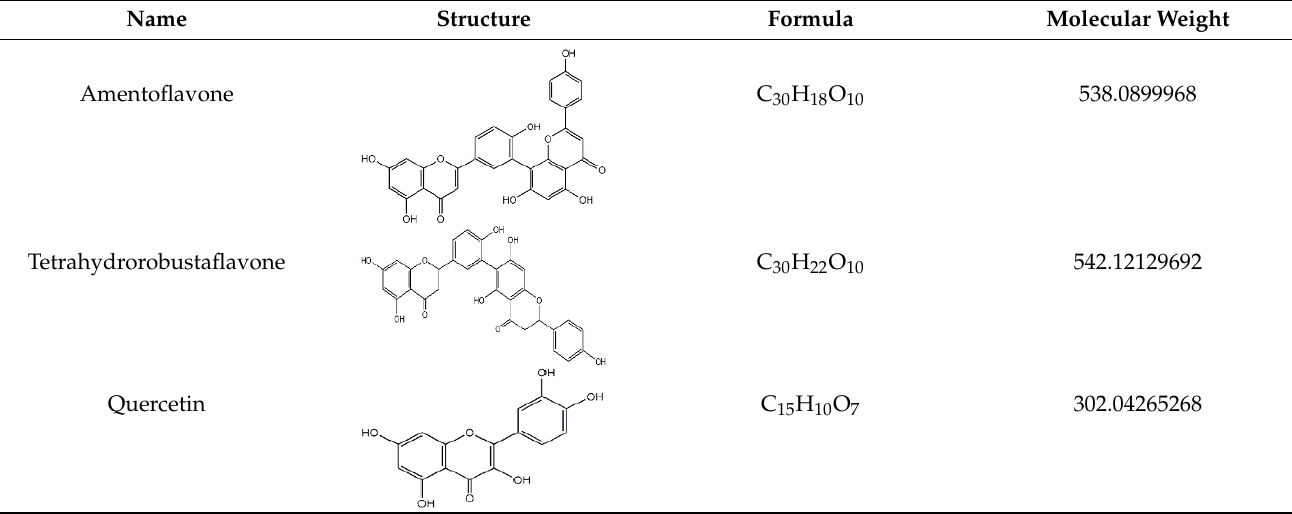
Table 3. Information summary of flavonoid compounds.